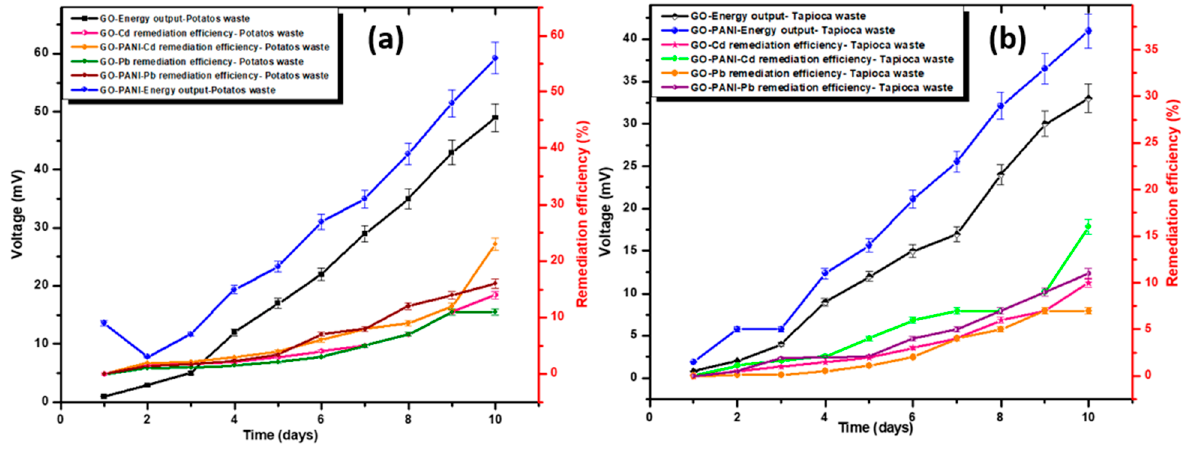
Figure 12. Effect of ( a ) potato waste and ( b ) tapioca waste as organic substrates on energy generation and remediation efficiency via BMFCs.